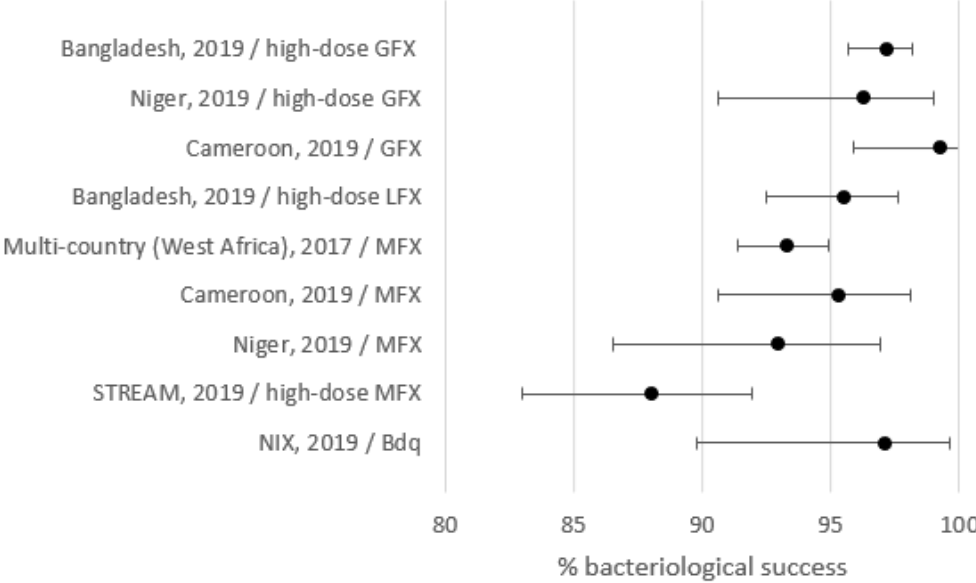
Figure 1. Treatment success by setting. GFX: gatifloxacin; MFX: moxifloxacin.